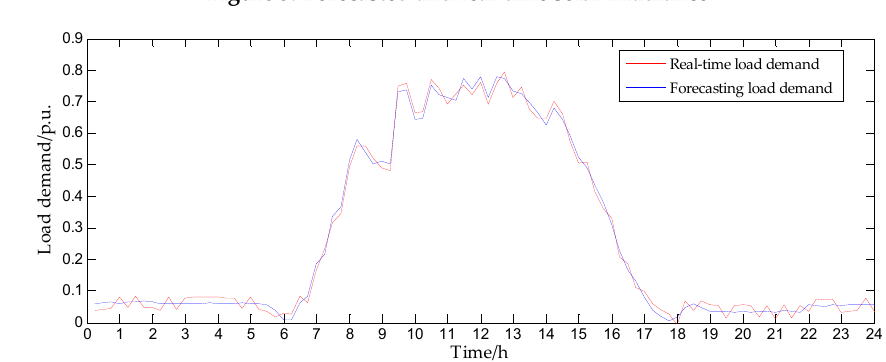
Figure 5. Forecasted and real-time solar irradiance.